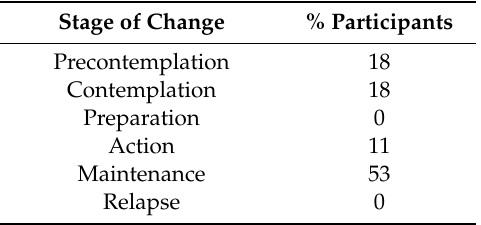
Table 2. Percentage of participants reporting each stage of change